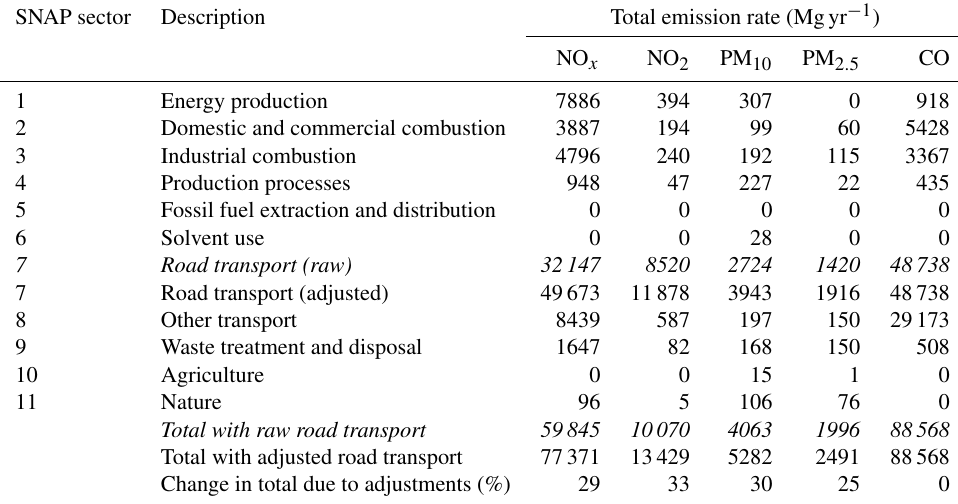
Table 2. Total emission rates within the LAEI area by SNAP sector, including the effects of real-world emission adjustments for NO x and PM from road transport (sector 7). Italic font indicates the road transport and total emissions with unadjusted (raw) emission